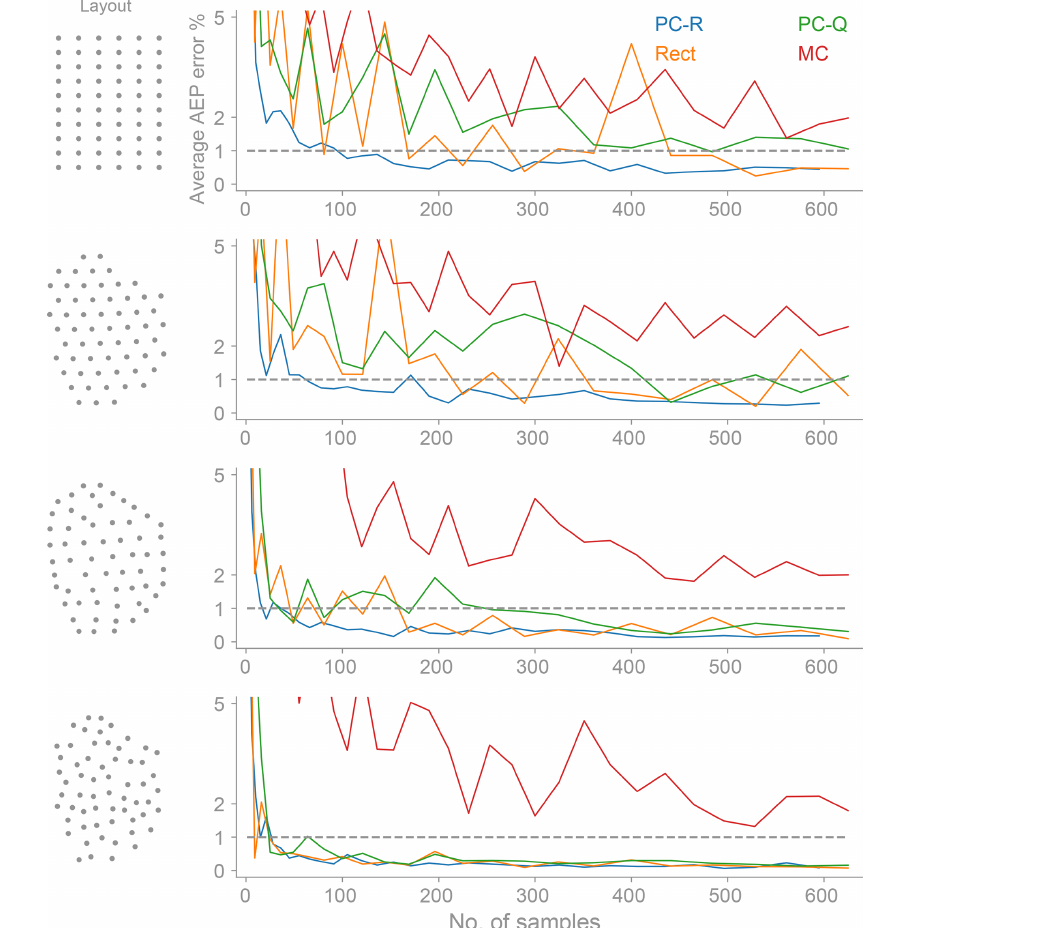
Figure 6. The average AEP error as a function of the number of samples for polynomial chaos (based on regression and quadrature), the rectangle rule, and Monte Carlo. The AEP is a function of two uncertain variables: the wind direction and wind speed. The polynomial chaos based on regression performs best for all